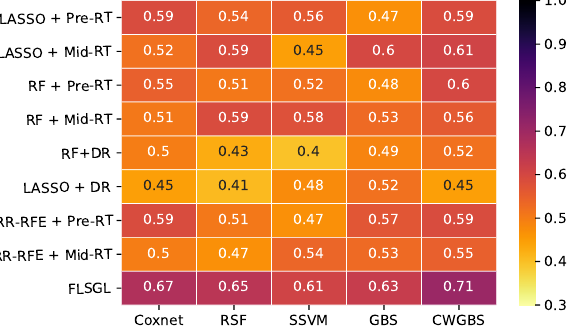
Figure 5. Heatmap of c-index values of overall survival prediction for different feature selection and survival analysis algorithms using FDG-PET radiomics (DR—delta radiomics; Coxnet—Cox net survival model; RR-RFE—ridge regression recursive feature elimination; RF—random forest; RSF—random survival forest; GBS—gradient boosting survival; SSVM—survival support vector machine; GBS—gradient boosting survival).